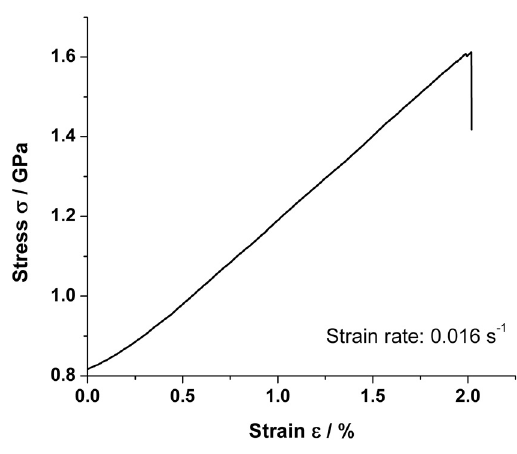
Co Al Ag bulk 57.52 21.24 9.24 12